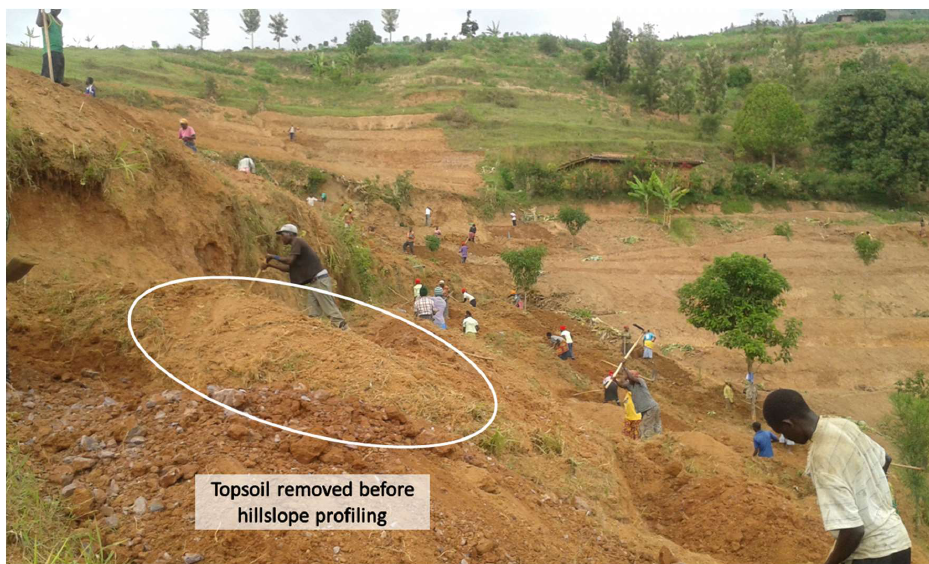
Figure 4. Practice of removing the topsoil and putting it apart before hillslope profiling during terraces implementation, according to Bekele-Tesemma, 2011 [22], Rwanda, photo of G. Castelli, 2017.